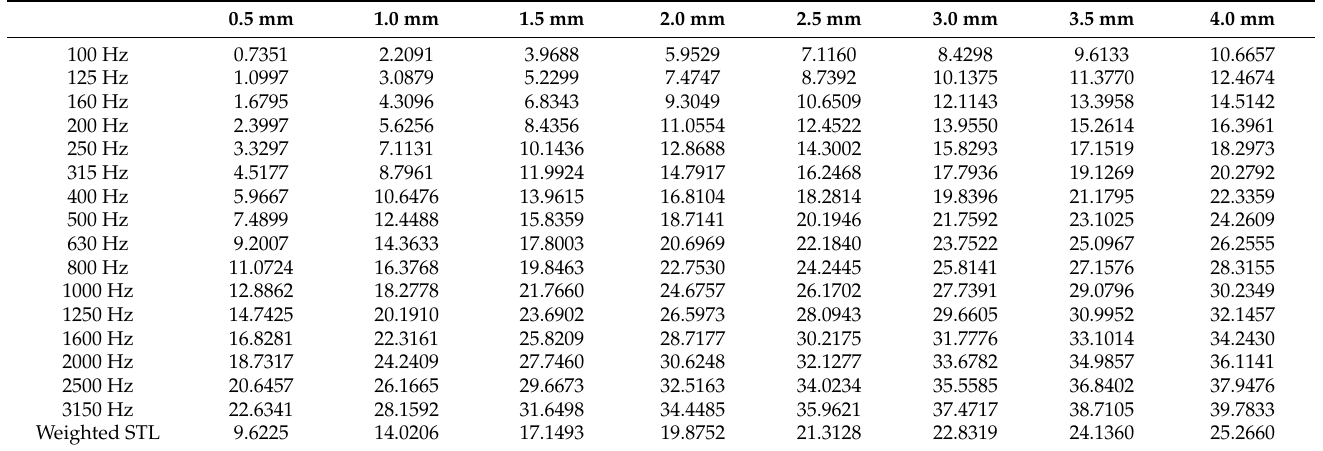
Table 12. The summarized STL data of the optimized composite rubber reinforced with HGM for the various